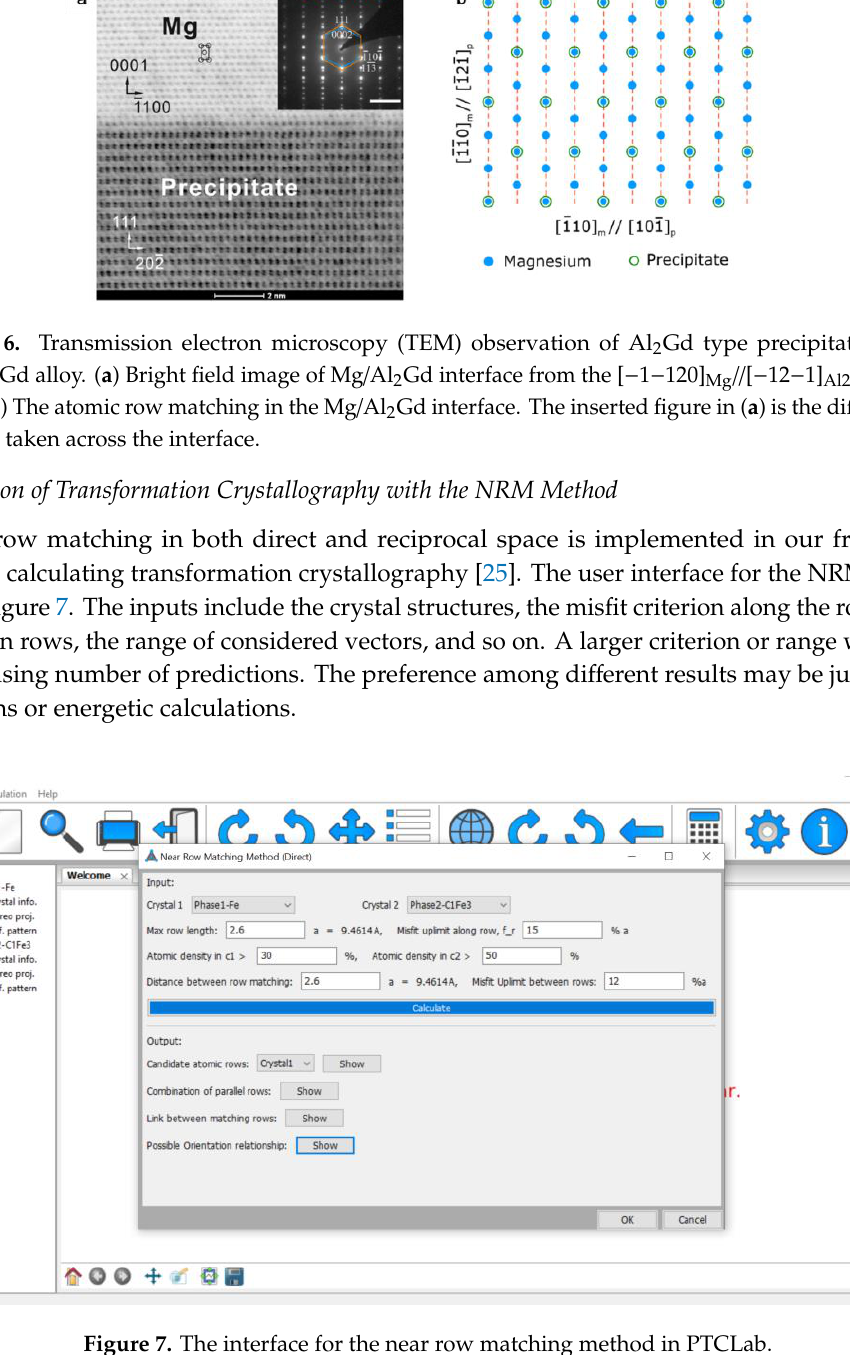
Table 1. Matched atomic rows or reciprocal rows between the face centered cubic (fcc) lattice and